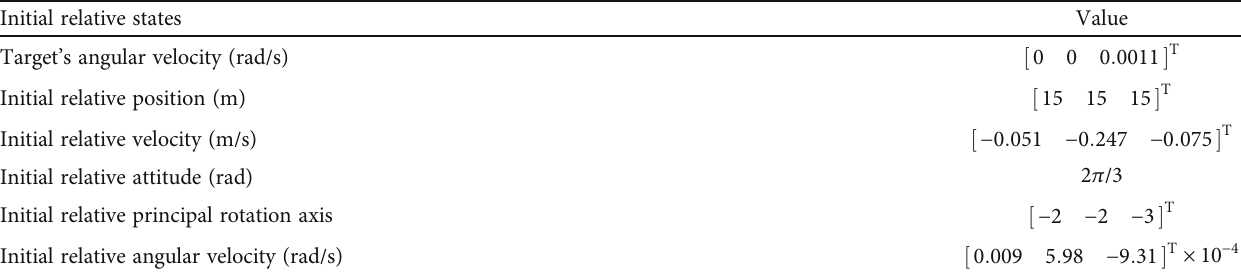
Table 2: Initial states of the chaser relative to the target [1, 43].